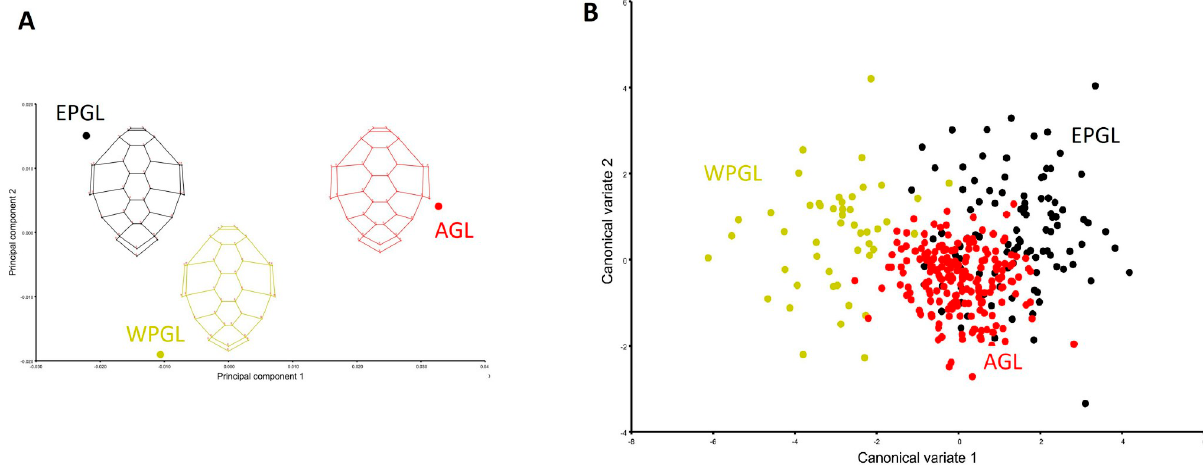
Fig 3. Difference in carapace shape between Chelonia mydas from different genetic lineages. (A) Principal component analysis of the average carapace shape (B) Scatterplot of first two axes of the canonical variate analysis. Eastern Pacific (EPGL): black; Western Pacific (WPGN): yellow, and Atlantic (AGL): red. � All the analyses have size effect